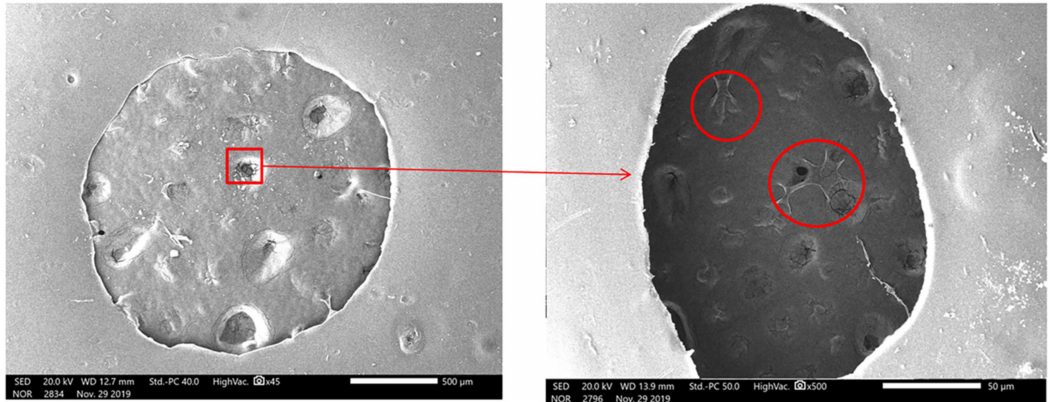
Figure 19. Scanning electron microscopic observations of chondrocytes cultured on sca ff old (x45 and X500).